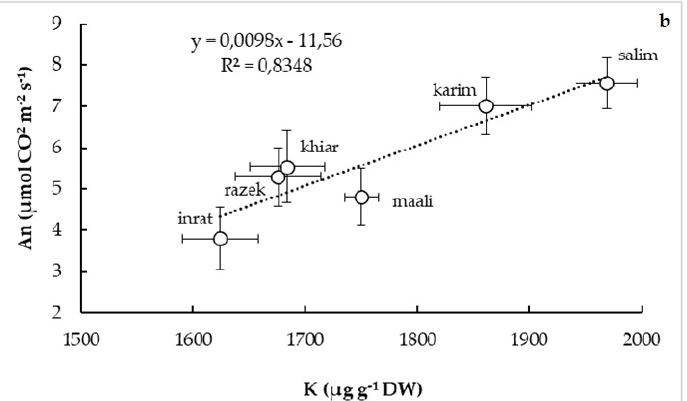
Figure 9. Relationship between biomass production (DW) and shoot K concentration ( a ) and between net photosynthesis (An) and shoot K concentration ( b ) in durum wheat ( Triticum durum Desf.) plants subjected to drought stress. Vertical standard errors of means of 30 replicates; horizontal standard errors of means of 10